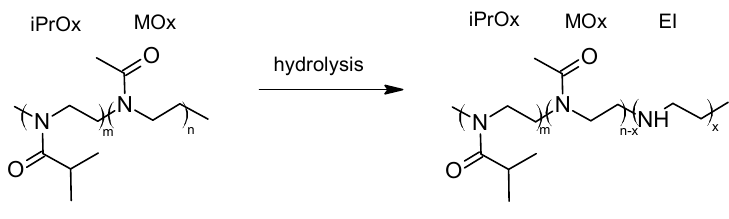
Figure 6. The selective alkaline reaction of hydrolysis.